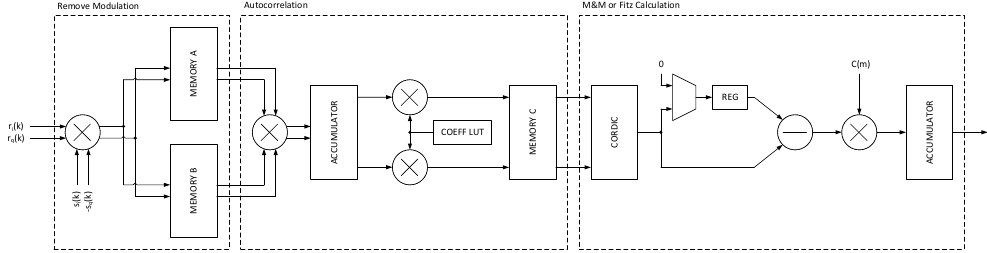
Figure 23. Multi-algorithm (M&M and Fitz) frequency estimator